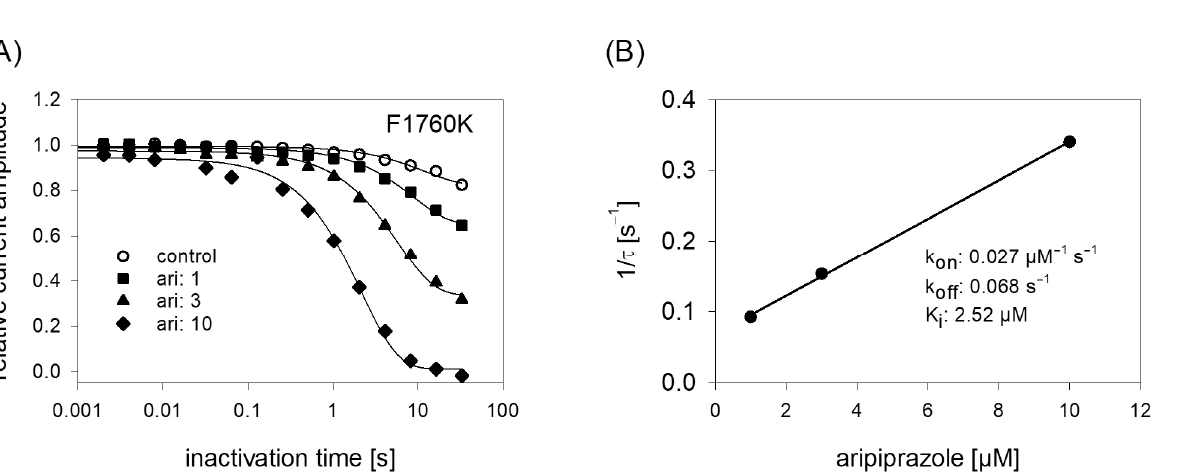
Figure 10. Interaction with the open state. ( A ) Original current traces obtained from the inactivation deficient mutant Nav1.5_CW in the absence and presence of different concentrations of aripiprazole. Individual activations were carried out from a holding potential of − 140 mV by stepping to − 20 mV for 50 ms. Drugs were preincubated for 60 s before individual activations were carried out. ( B ) For evaluation, relative plateau current amplitudes (measured at the end of the depolarization) were plotted versus the concentration of aripiprazole (the amplitude obtained for control was set to 1). Data fitting according to Equation (1) revealed fit parameters of this experiment as illustrated. K o indicates the affinity for the open state. Altogether, an affinity for the open state of 0.94 ± 0.25 μ M was estimated.